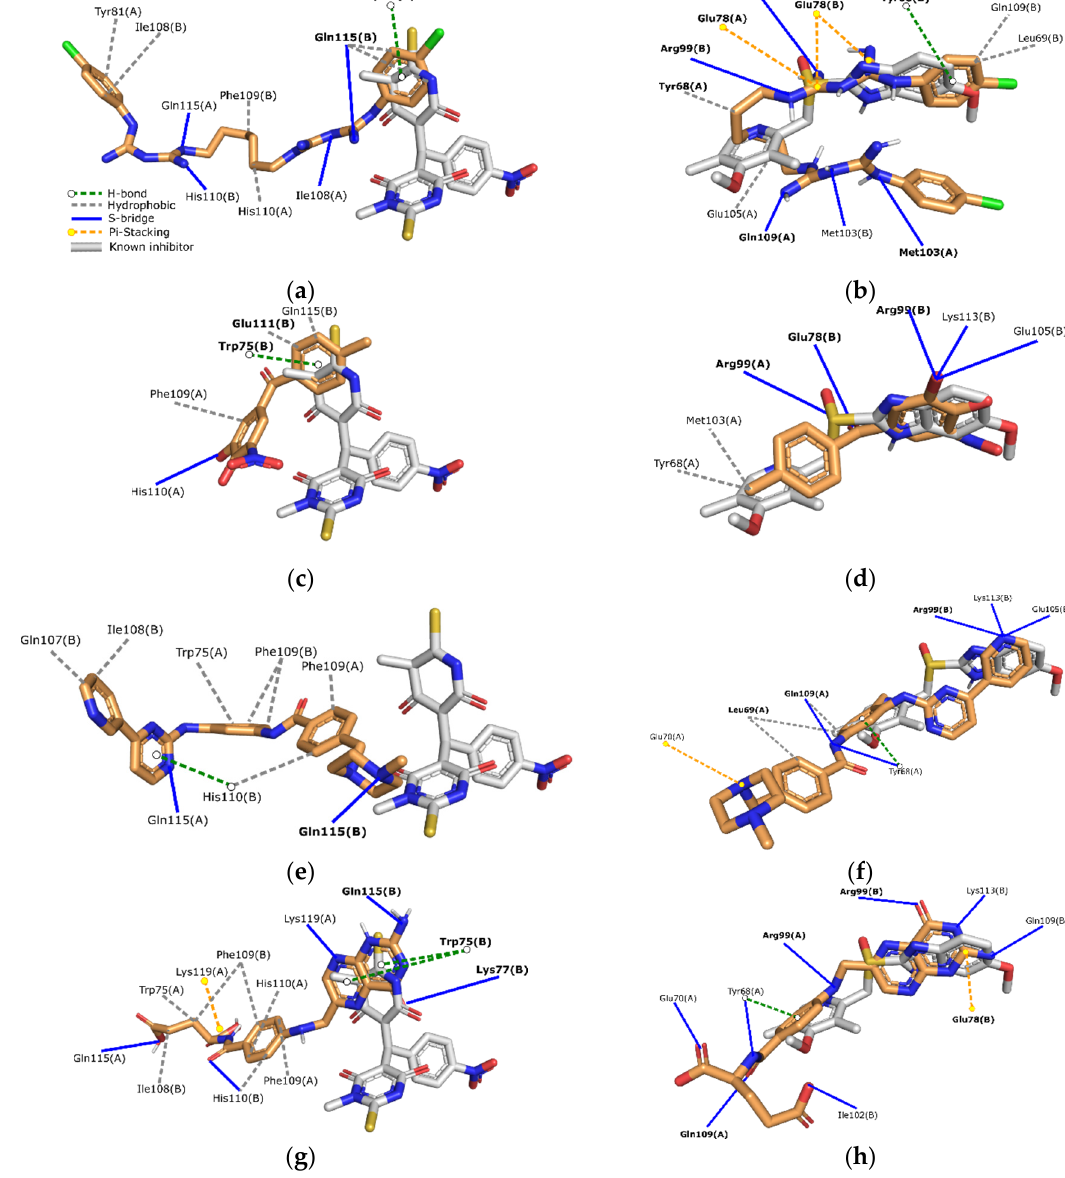
Figure 3. Interaction diagram of selected compound in complex: ( a ) Chlorhexidine on TIM Eh ; ( b ) Chlorhexidine on TIM Gl ; ( c ) Tolcapone on TIM Eh ; ( d ) Tolcapone on TIM Gl ; ( e ) Imatinib on TIM Eh ; ( f ) Imatinib on TIM Gl ; ( g ) Folic acid on TIM Eh ; ( h ) Folic acid on TIM Gl . Residues in bold text represent interactions shared with the known inhibitor.